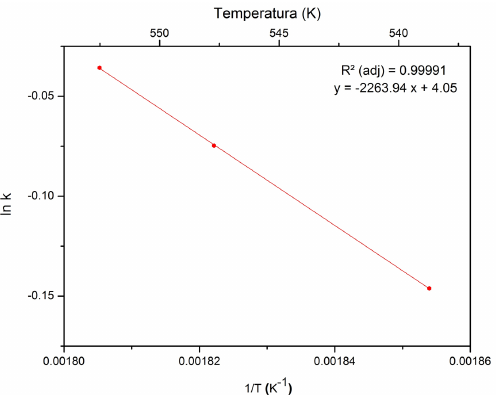
Figure 8. Arrhenius plot of ln k vs 1/T for estimation of thermodynamic parameters. Bibliographic source: Author.